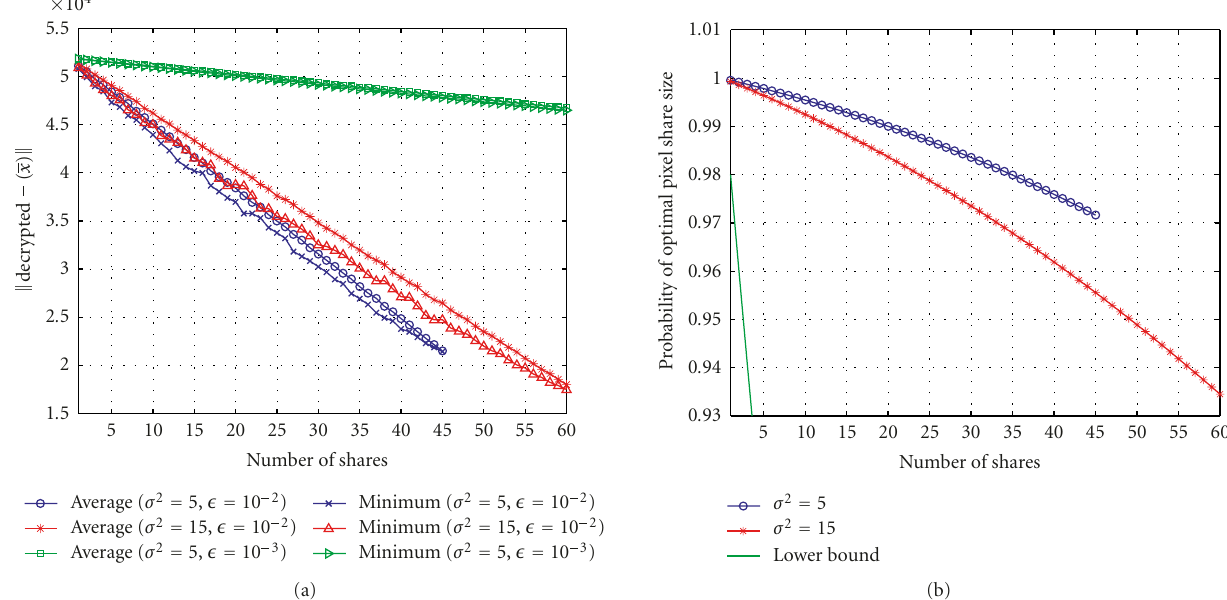
(cid:26) n u k − x (cid:5) as a function of the number of shares n ; (b) Pr { k = 0